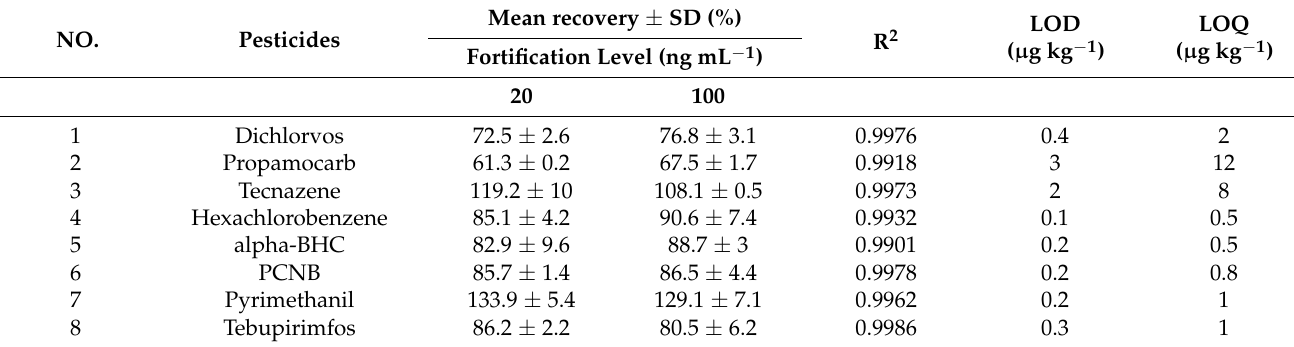
Table 2. The mean recovery, SD, LOD and LOQ of each